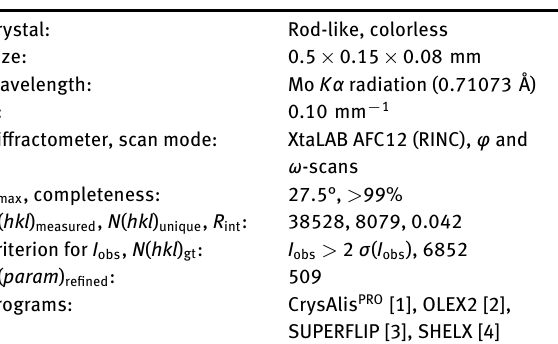
Table 1: Data collection and